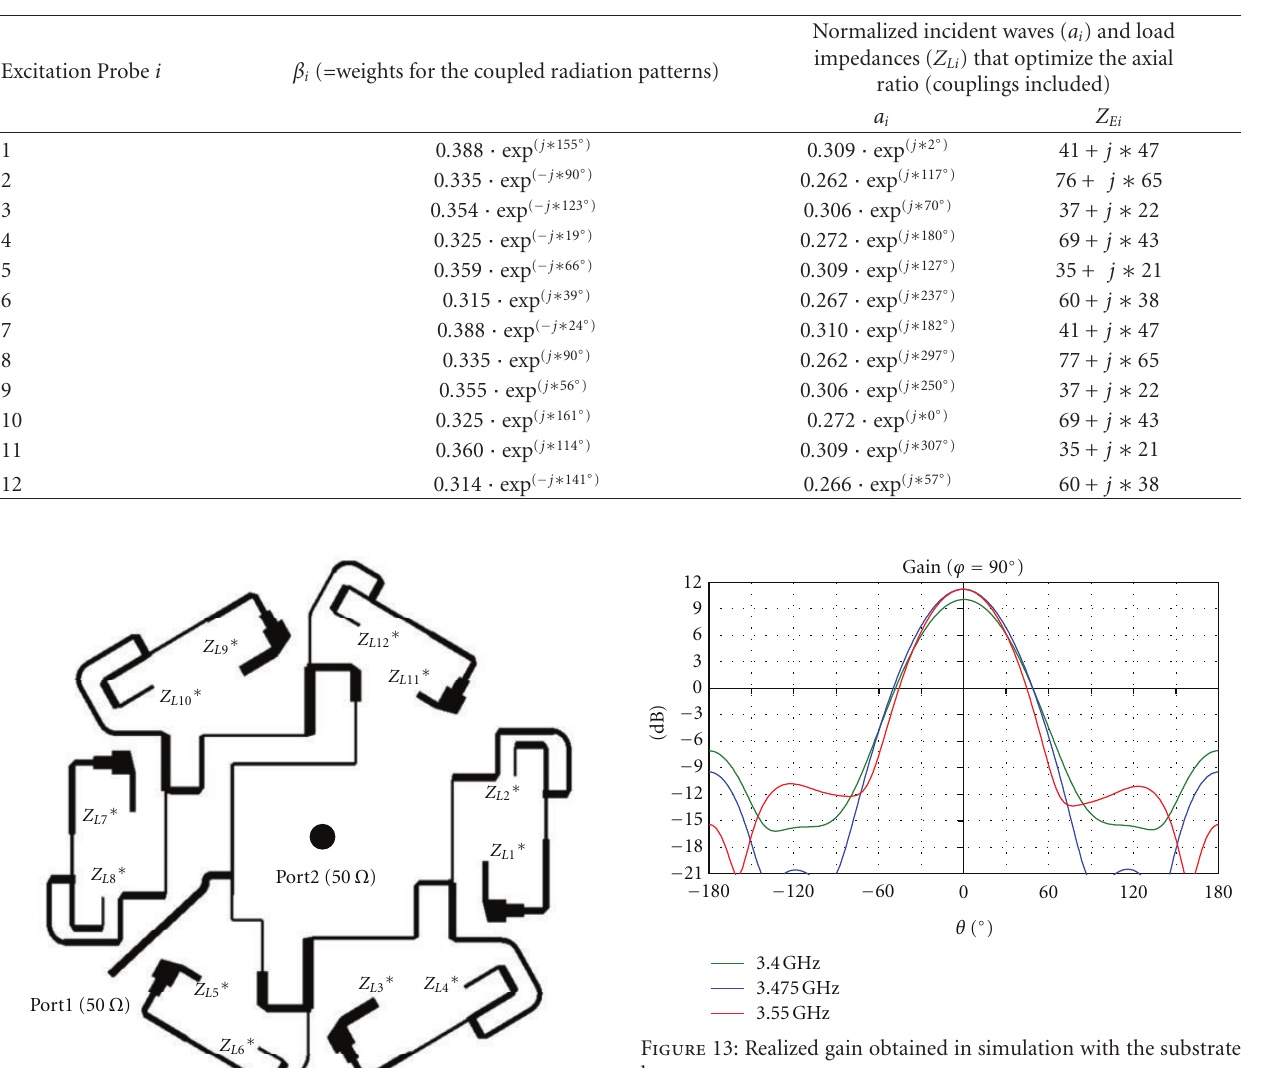
Table 3: Results of the synthesis procedure for the 6 patch-array.